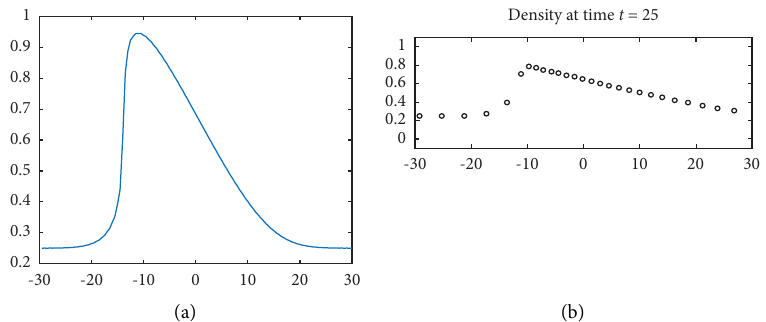
Figure 4: A comparison of the solution of equation of example 1 using the present method with the solution in Ref. [52].